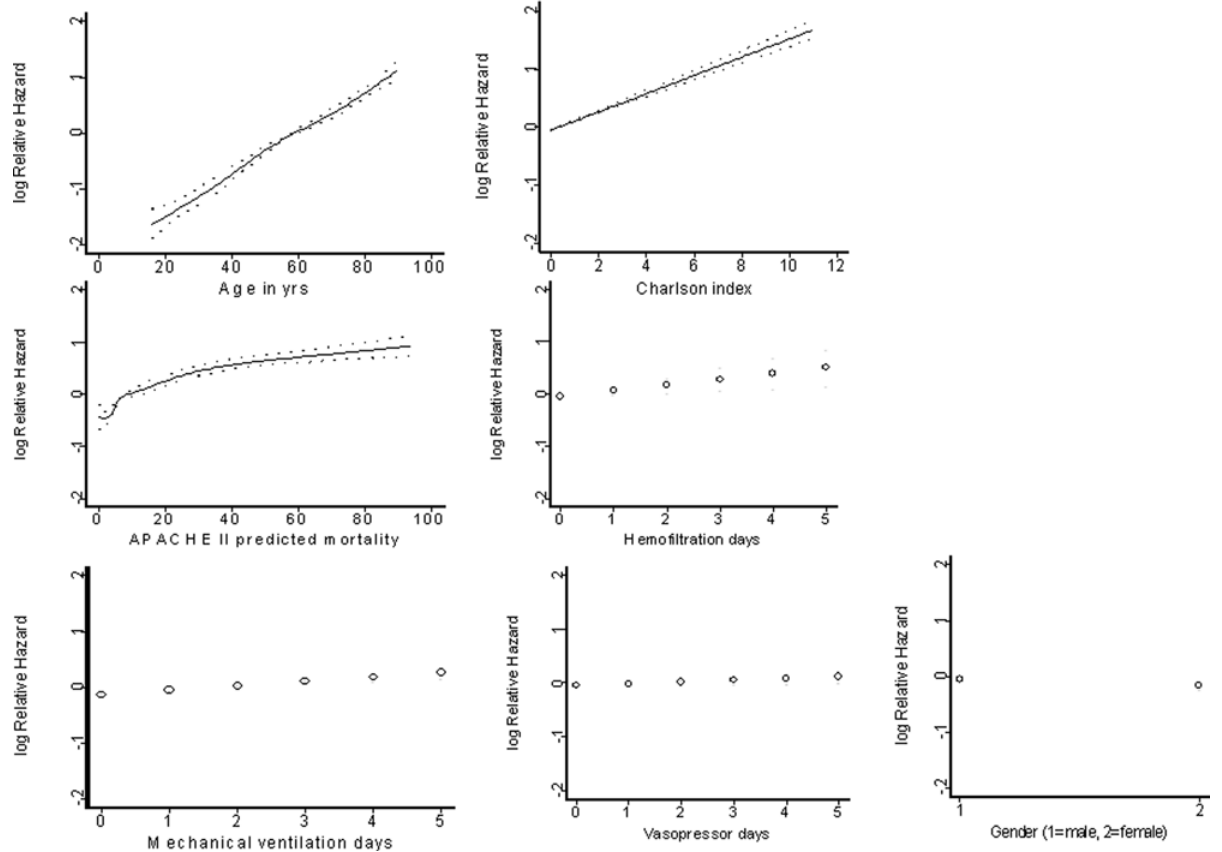
Figure 3. The relationship between relative hazard and each predictor after adjusting for other predictors in the model.